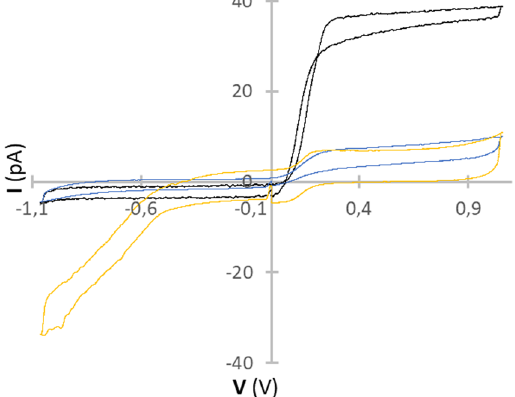
Figure 2. Electrochemical characterization of nanoelectrodes vs Ag/AgCl. Cyclic voltammograms in 1 mM ferrocene methanol in PBS of a nanoelectrode: black graph – disk shape initial carbon electrode; blue graph – electrode after etching in NaOH solution; yellow graph – platinized